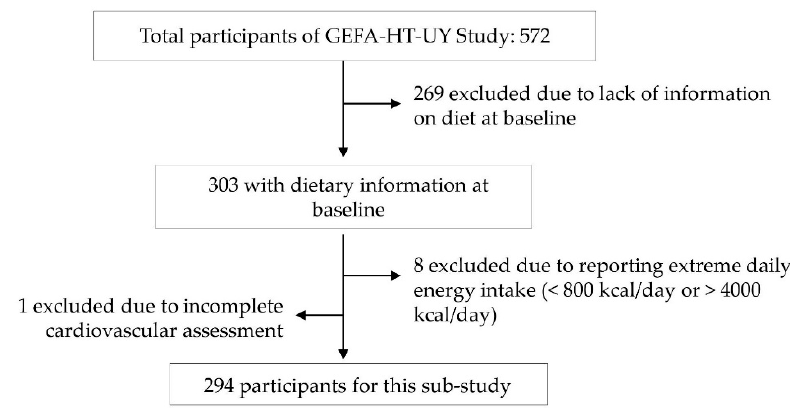
Figure 1. Flow chart of participants. GEFA-HT-UY: Genotype Phenotype and Environment of Hypertension in Uruguay Study.